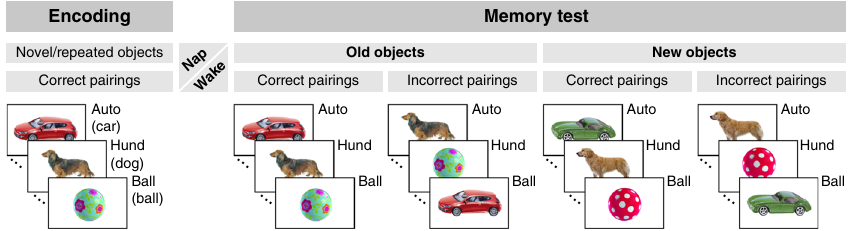
Fig. 1 The experimental design. In the encoding session, infants were exposed to known words presented in semantically correct object contexts. Each initially novel object – word pair was repeated once within about a minute. In the retention period, half of the infants napped while the other half stayed awake. In the memory test after the retention period, infants were re-exposed to the same words. The words were now presented both in the same episodic context as during encoding, i.e., with old semantically correct objects, and in three different contexts: with old but semantically incorrect objects, with new semantically correct objects, and with new semantically incorrect